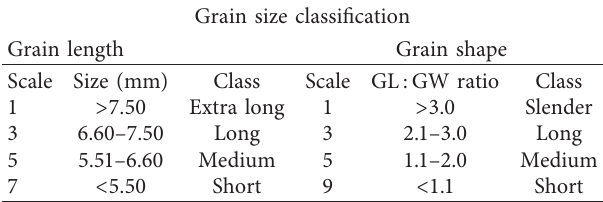
Table 3: Grain size and grain shape classification. Grain size